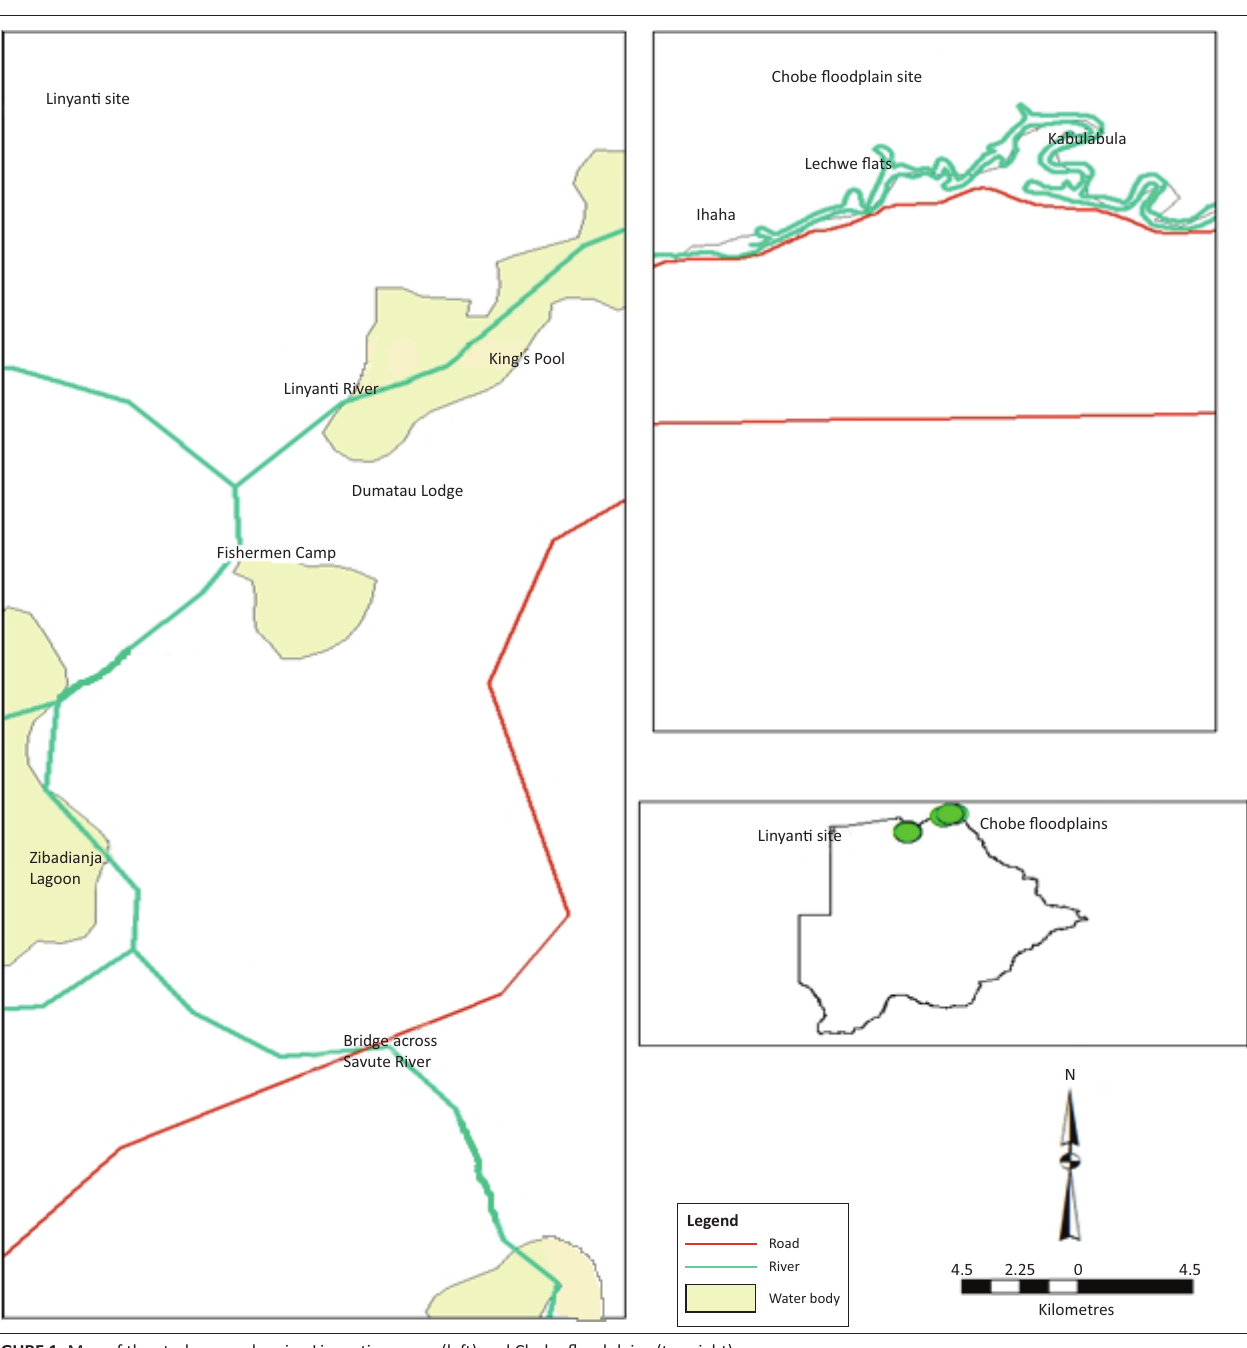
FIGURE 1: Map of the study area, showing Linyanti swamps (left) and Chobe floodplains (top